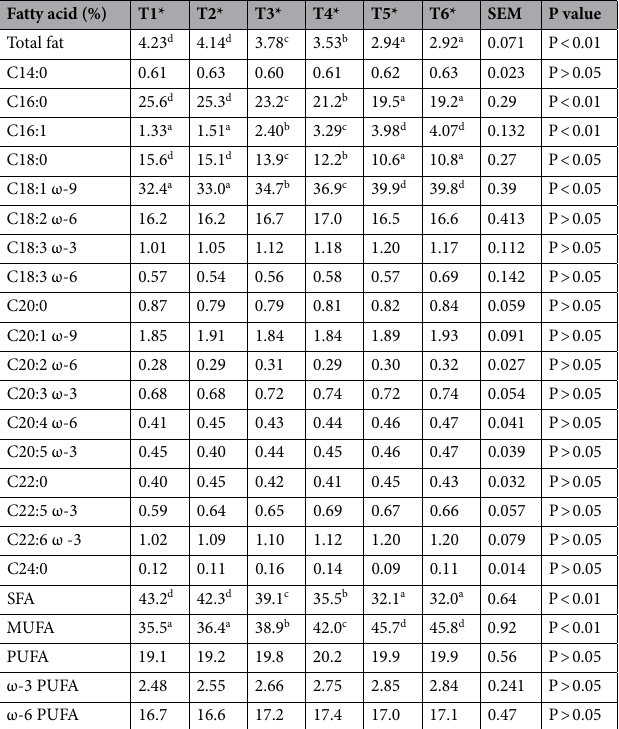
Table 1. Effect of dietary supplementation of Bifidobacterium bifidum (BFD) and Mannan-oligosaccharides (MOS) on fatty acid profile of broiler chicken breast muscle (n = 6 × 2). *T1 (no BFD/MOS/BMD), T2 (20 mg BMD/kg diet), T3 (0.1% MOS + 10 6 cfu BFD/g feed), T4 (0.1% MOS + 10 7 cfu BFD/g feed), T5 (0.2% MOS + 10 6 cfu BFD/g feed), T6 (0.2% MOS + 10 7 cfu BFD/g feed). BMD Bacitracin Methylene Disalicylate, SFA Saturated fatty acids, MUFA Monounsaturated fatty acids, PUFA Polyunsaturated fatty acids, SEM Standard error of mean. Mean values bearing the same superscripts in a row do not differ